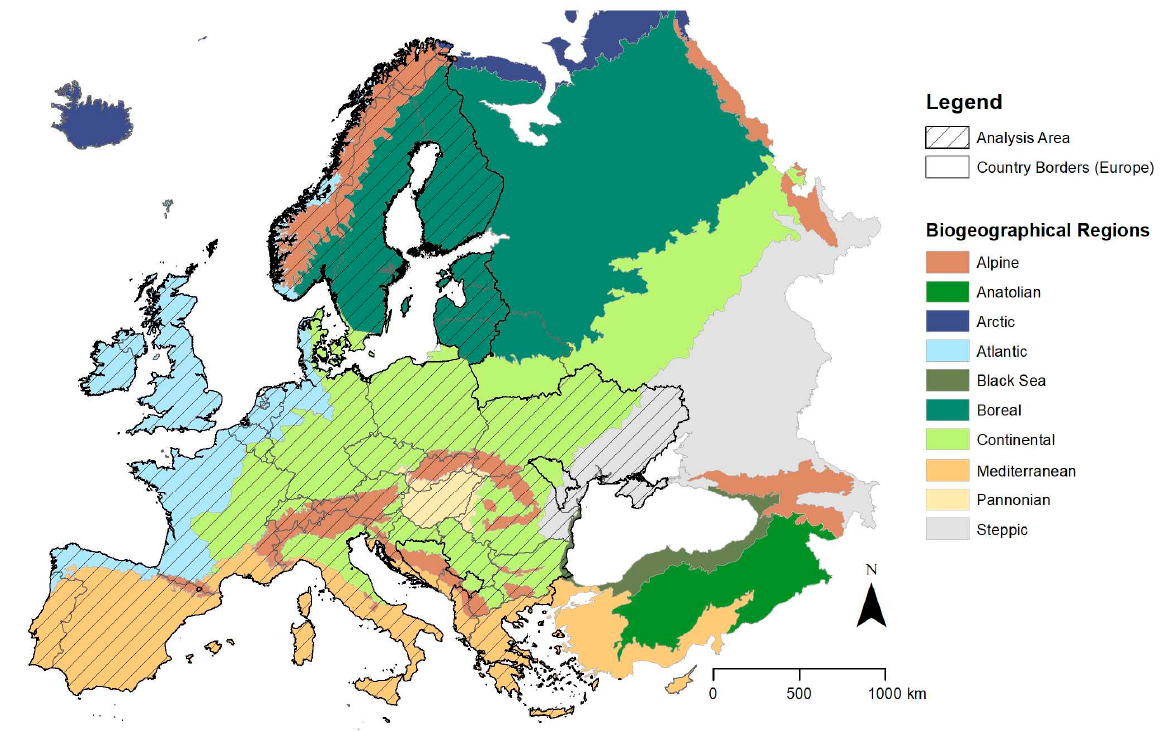
Figure 1. Study area and stratification for processing.